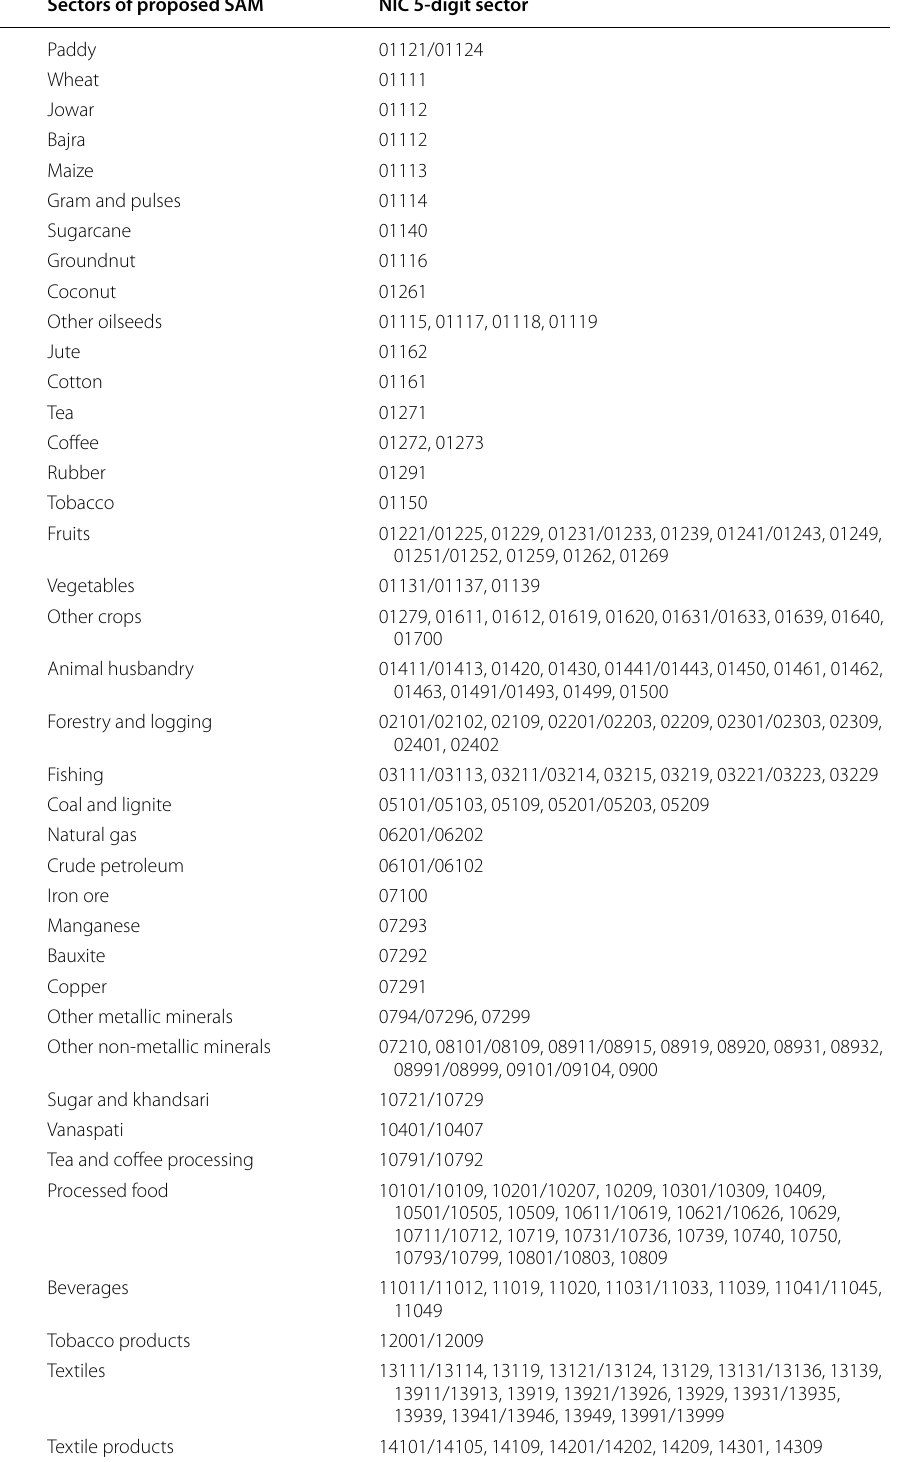
Table 9 Map of concordance between sectors of our SAM and NIC 5‑digit classification of Indian